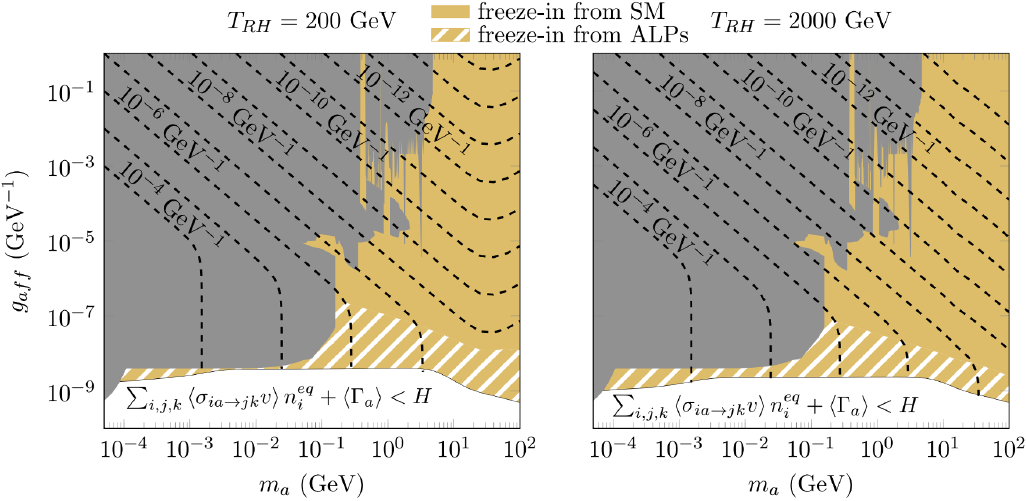
Figure 5 . ALP-fermion coupling g aff as a function of m a for lines of constant hidden-sector coupling g (plotted in dashed black) which reproduce the observed DM relic density via freeze- aχχ in from SM and freeze-in from ALPs as indicated for reheating temperatures T and T = 2000 GeV (right). We fixed the ratio m RH of g for which the ALPs and the SM reach equilbrium. In grey, we have included the relevant aff constraints on our ALP model on the connector coupling g